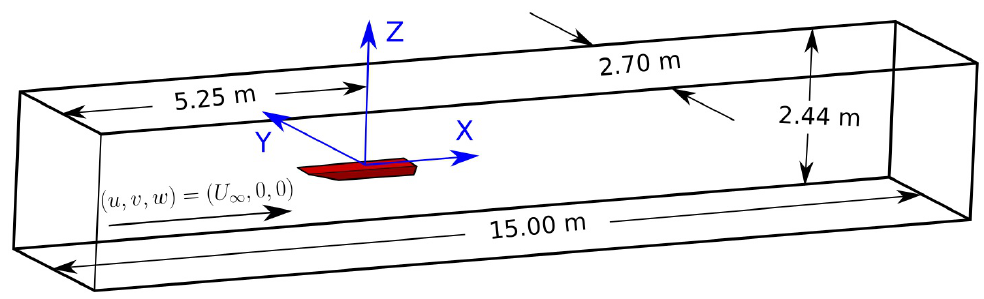
Figure 1. Schematics of the M219 cavity used in the wind tunnel experiment. Length units in inches. Positions for the Kulite transducers are indicated by red markers. L , W , and D are the cavity length, width, and depth, respectively.